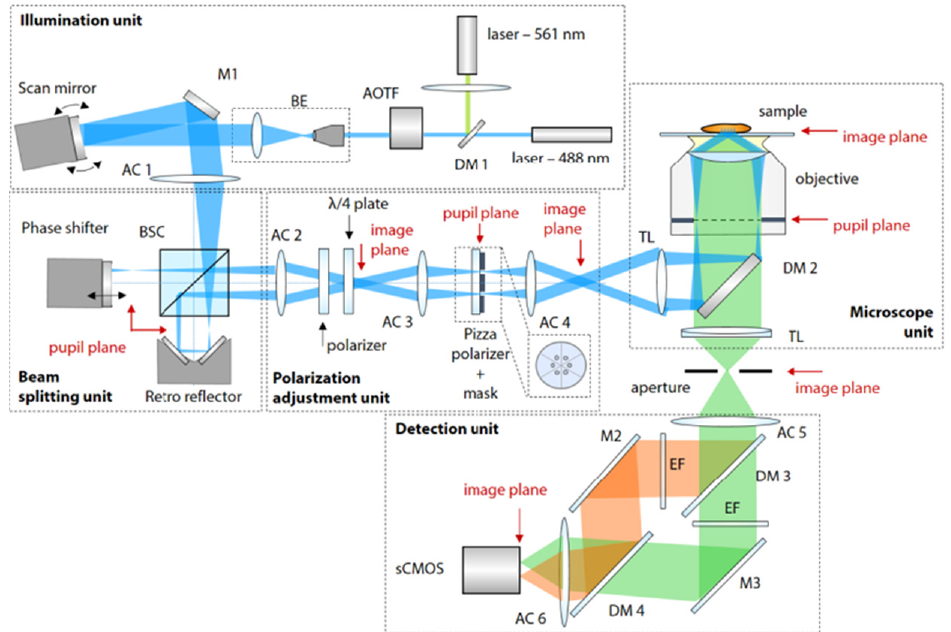
Figure 7. SIM-TIRF with a Michelson interferometer [75]. The system comprises five parts: an illumination unit, beam splitting unit, polarization adjustment unit, microscope unit, and a detection unit. In the illumination unit, the excitation beam is incident on a piezo scan mirror to displace it and achieve total reflection. The beam splitting unit replaces the SLM with a Michelson interferometer to split the beam into the two beams required for structural illumination in the sample plane.